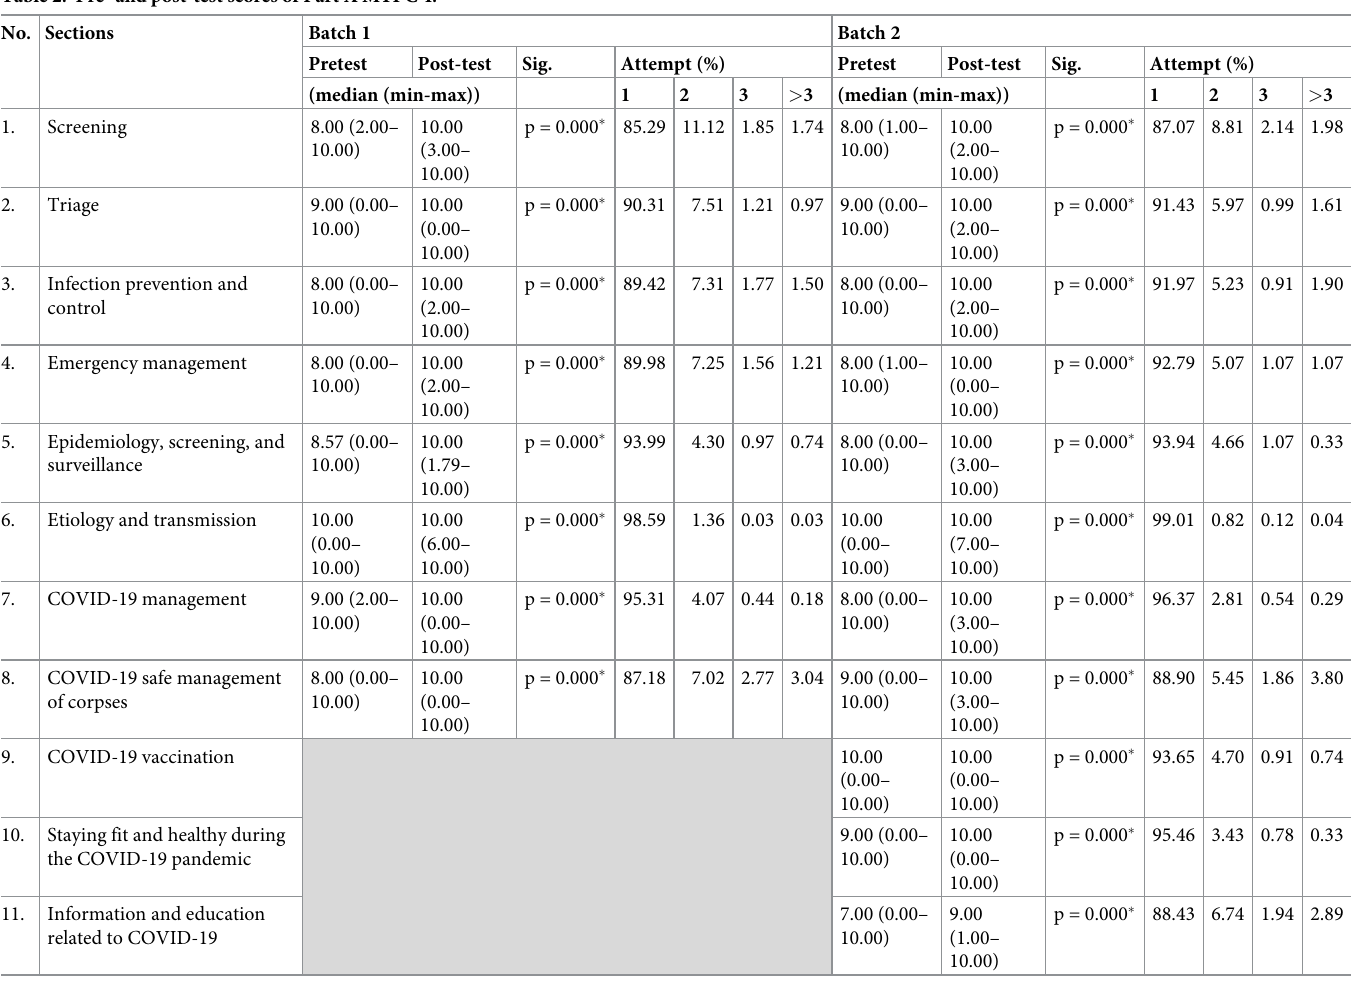
Table 2. Pre- and post-test scores of Part A